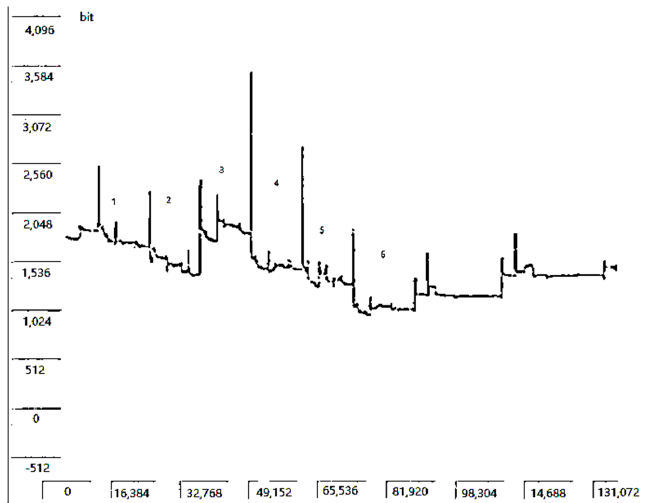
Figure 24. The Gatling bolt acceleration curve at the sampling frequency of 50 kHz. Note: 1— graduated arc, 2—main roller axis, 3—working part axis, 4—mechanism carriage axis, 5—graduated arc, 6—box mechanism